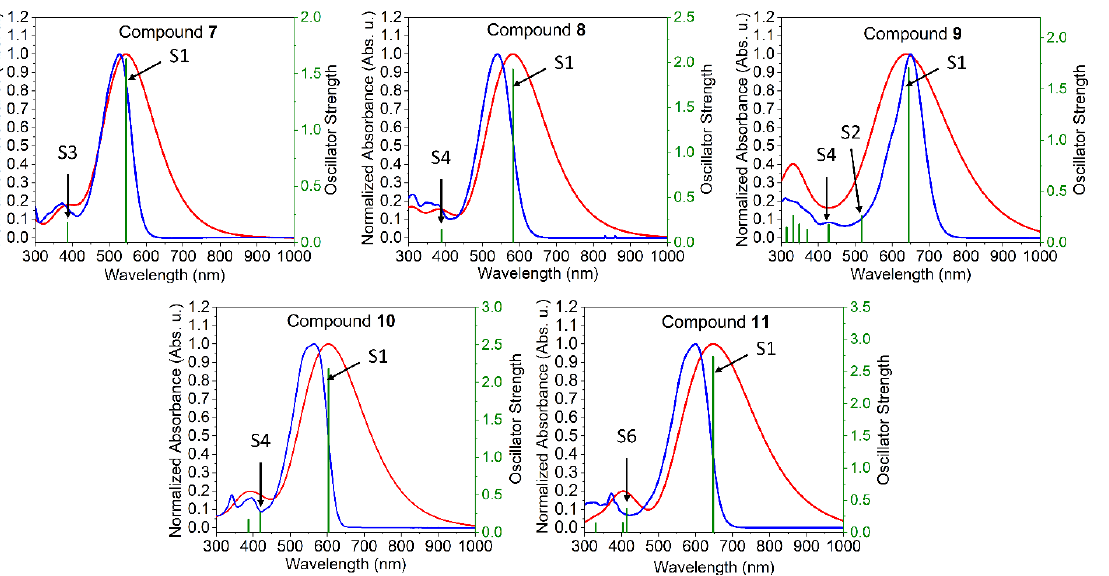
Figure 4. Experimental (blue lines) and theoretical (red lines) UV-vis spectra of compounds 7 – 11 , as well as the relevant excited electronic states with an oscillator strength higher than 0.15 (olive lines). Concerning the low-energy absorption bands, their theoretical absorption maxima ranges from 546 nm to 645 nm within the D-A series and from 604 to 648 nm in the A-D- A type compounds, depending on the type and number of EWGs attached on the bi-TT core. Moreover, the theoretical bandgap (HOMO-LUMO) (E gap , Table 1) trend follows the